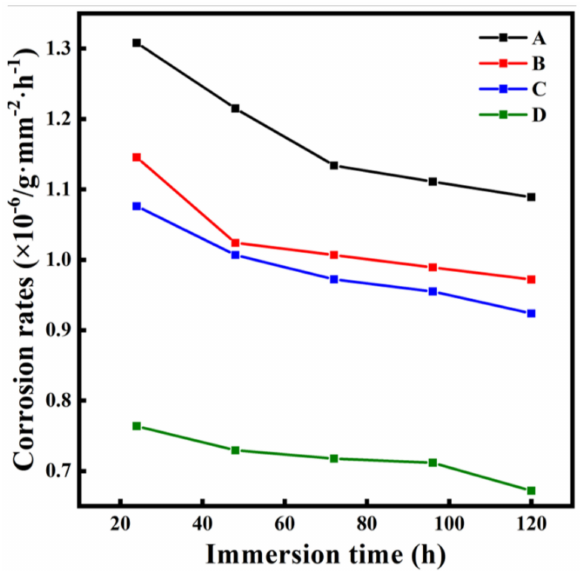
Figure 11. Corrosion rates of the cermets with different Ta contents as a function of time in 0.5 mol/L HNO 3 solution, A-0 wt.% Ta, B-1 wt.% Ta, C-3 wt.% Ta, and D-5 wt.%